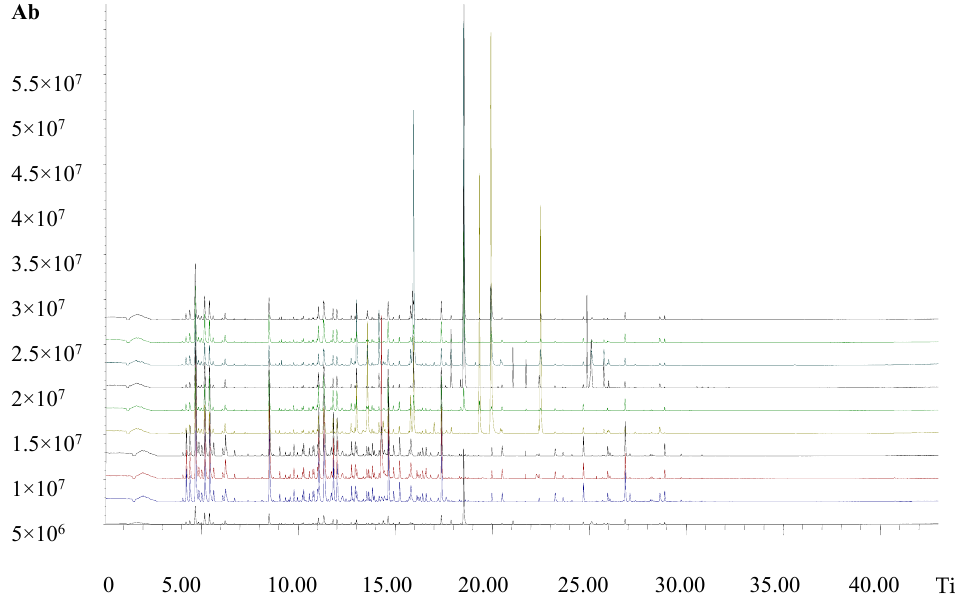
Figure 2. Typical total ion chromatogram of the volatile compounds in Chrysanthemum morifolium flowers. From top to bottom, Dendranthema morifolium (Ramat.) Yellow ( No.1 ), Pericallis hybrida Blue ( No.5 ), Pericallis hybrida Pink ( No.6 ), Pericallis hybrida Purple ( No.7 ), Dendranthema morifolium (Ramat.) Red ( No.2 ), Dendranthema morifolium (Ramat.) Pink ( No.3 ), Dendranthema morifolium (Ramat.) White ( No.4 ), Bellis perennis White ( No.10 ), Bellis perennis Pink ( No.8 ), and Bellis perennis Yellow ( No.9 ), respectively.